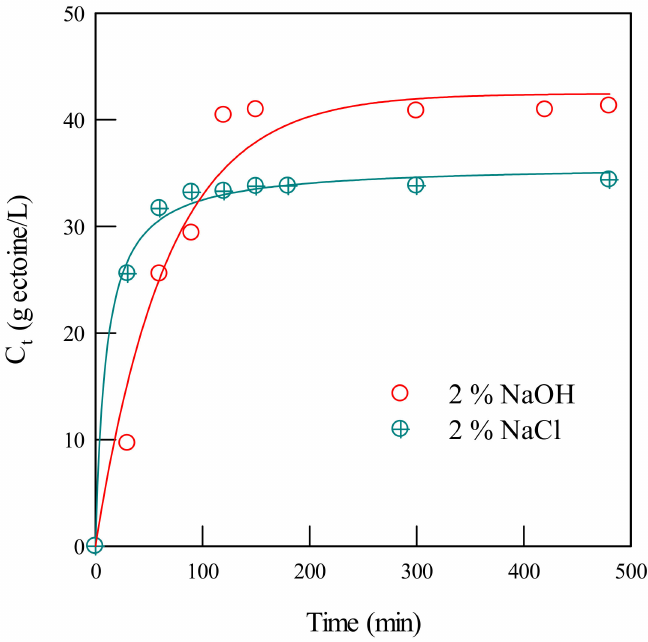
Figure 12. Comparison of NaOH and NaCl in ectoine desorption (temperature: 35 ◦